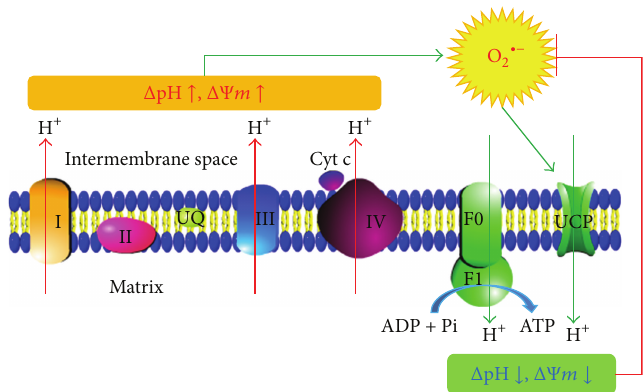
Figure 2: “Antioxidative activity” of UCP. High transmembrane proton gradient and membrane potential of mitochondria will induce ROS production and thus oxidative damage; these ROSs may activate UCPs and therefore cause a “mild uncoupling” and (as a negative feedback) will prevent further superoxide production and decrease oxidative damage. Δ pH: transmembrane proton gradient; ΔΨ𝑚 : mitochondrial membrane